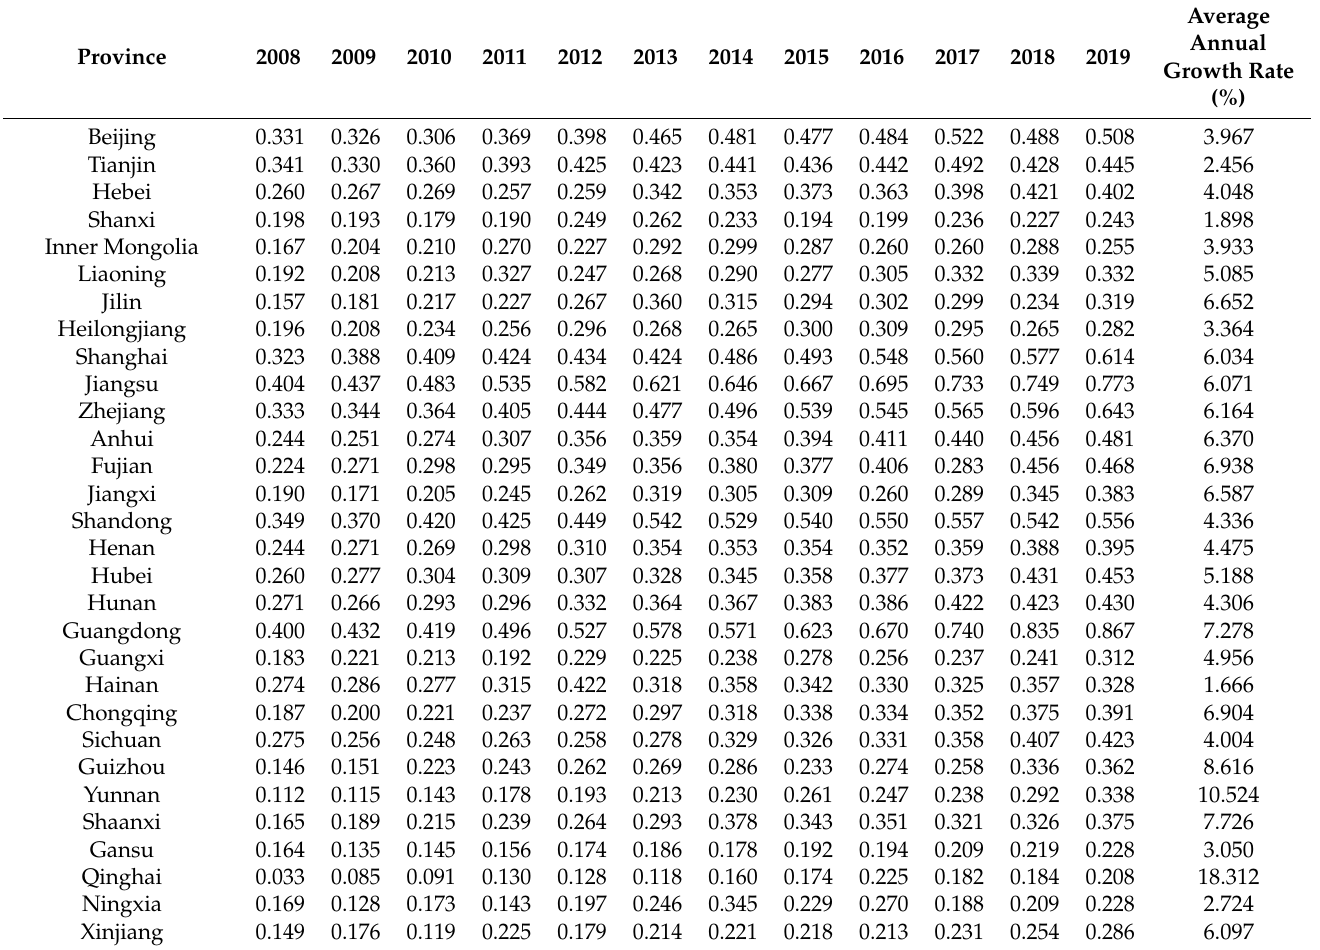
Table 2. Annual measurement results of HQDM total index by province.